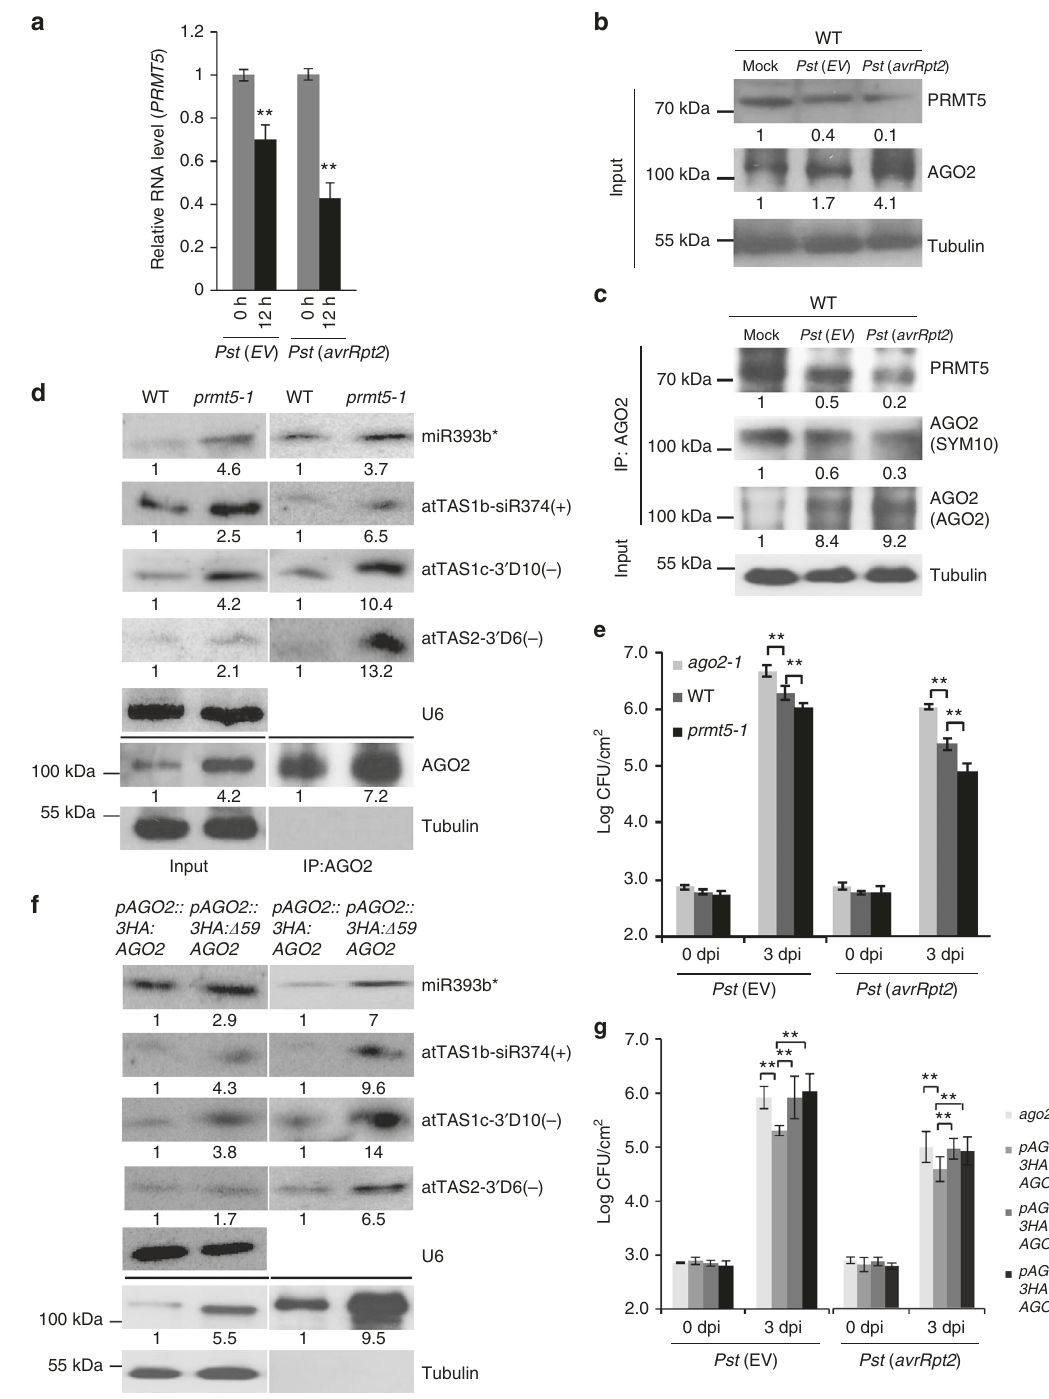
Fig. 3 PRMT5 modulates plant innate immunity. a PRMT5 expression is downregulated in leaves 12 h after bacterial infection with Pst ( EV ) or an avirulent strain Pst ( avrRpt2 ). Error bars represent the standard deviation. b PRMT5 protein expression is downregulated in leaves 12 h after bacterial infection, whereas the level of AGO2 protein is induced. c The levels of AGO2 methylation and the PRMT5 protein are reduced after bacterial infection, whereas the AGO2 protein is accumulated to a higher level. Protein levels were measured in WT leaf tissue 12 hours post inoculation. d Accumulation of miRNA393b*, atTAS1b-siR374( + ), atTAS1c-3 ’ D10( – ), and atTAS2 – 3 ’ D6( – ) is higher in the prmt5 – 1 mutant compared to the wild type (Col-0) before and after AGO2 IP. e The prmt5 – 1 mutant shows enhanced resistance 3 days post inoculation with Pst ( EV ) and Pst ( avrRpt2 ) strains compared to ago2-1 and WT controls. f The levels of AGO2 protein and the AGO2-associated sRNAs are higher in pAGO2:3HA: Δ 59 AGO2 lines. g Two independent transgenic lines, pAGO2:3HA: Δ 59 AGO2-1 and pAGO2:3HA: Δ 59 AGO2-2 , were more susceptible to Pst (avrRpt2) , and re fl ects similar bacterial growth levels in the ago2-1 mutant 3 dpi. sRNA levels were determined by Northern blot using U6 RNA to show equal loading. Tubulin levels were used to show equal loading for all Western blots. Error bars represent the standard deviation from the mean of ten 8-mm leaf disk measurements. Asterisks indicate mean values signi fi cantly different than wild-type controls using the Student ’ s T test (** P -value < 0.01). In all panels, signal intensity was calculated using